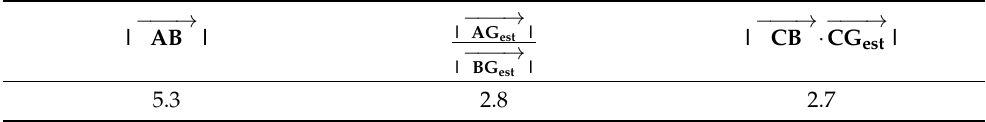
Table 2. VIFs for the selected features in the random forest analysis.